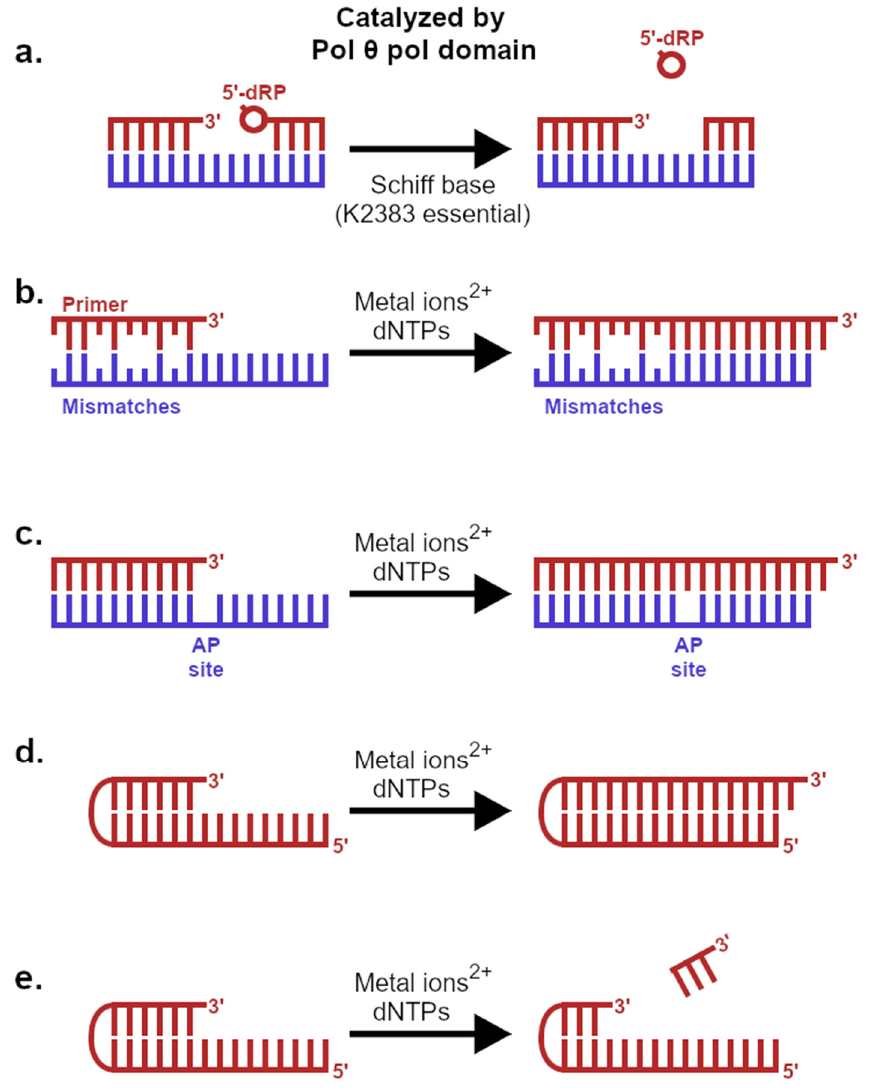
Figure 3. The pol domain of pol θ catalyzes multiple DNA-modifying activities. ( a ) 5 (cid:48) -dRP lyase activity removes ribose fragments. ( b ) Minimally primed, template-directed primer extension. Pol θ adds a single nucleotide to a blunt duplex, establishing a 3 (cid:48) -overhang. ( c ) Translesion primer extension opposite blocking lesions such as AP sites. ( d ) Intramolecular snapback synthesis via a hairpin structure. ( e ) Deoxy-NTP-dependent 3 (cid:48) -end trimming.